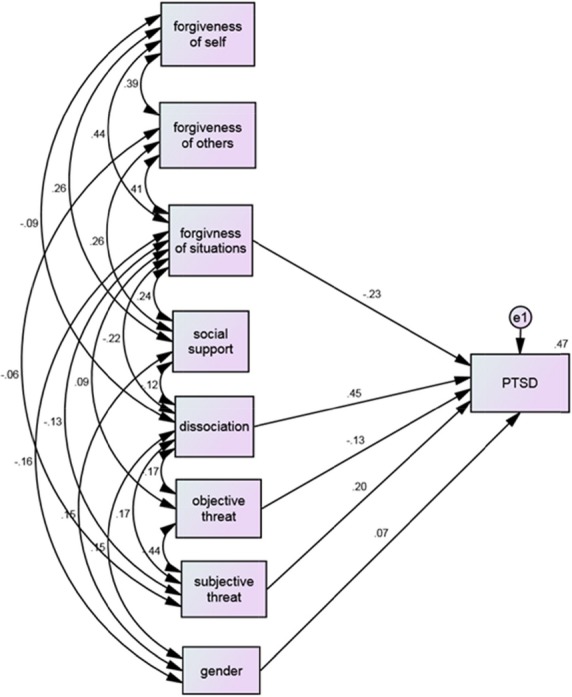
Structural equation model (SEM) for PTSD risk factors, e1 = dependent variable. Note: With regard to the significance of the associations between the risk factors and PTSD symptoms, for all of the associations P < 0.001 except for gender (P = 0.03). With regard to the significance of correlations between the risk factors, the significance for all of the correlations were P < 0.001, except for: dissociation and social support (P = 0.004), dissociation and forgiveness of self (P = 0.02), and forgiveness of situations and objective threat (P = 0.02).